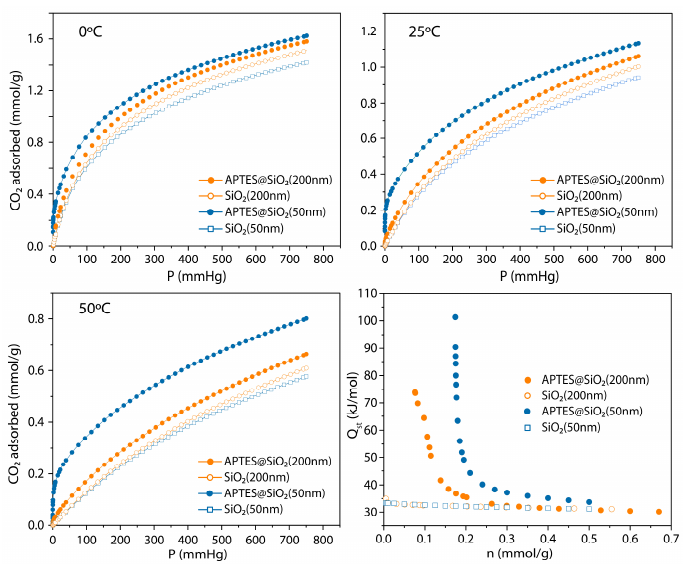
Figure 10. CO 2 adsorption isotherms at 0, 25, and 50 °C for pristine and functionalized SiO 2 nanoparticles of 50 and 200 nm. Isosteric heat of adsorption (Q st ).